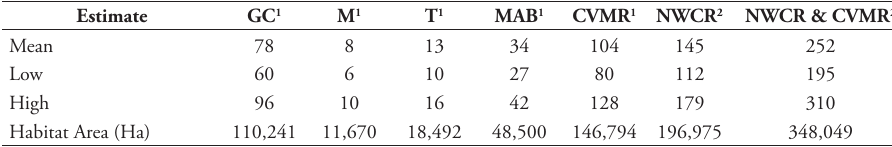
Table 3. Estimated population sizes of jaguar ( Panthera onca ) that could be supported in 1 current con- tiguous protected areas, 2 proposed contiguous protected areas connected by biological sub-corridors and habitat areas for each location. GC = Guanacaste Complex, M = Miravalles, T = Tenorio, MAB = Mon- teverde-Arenal Bioregion, CVMR = Central Volcanic Mountain Range, NWCR = Northwest Costa Rica including GC, M, T, MAB and three proposed corridors (Table 1), NWCR & CVMR = All protected areas and proposed corridors from Northwest Costa Rica + Central Volcanic Mountain